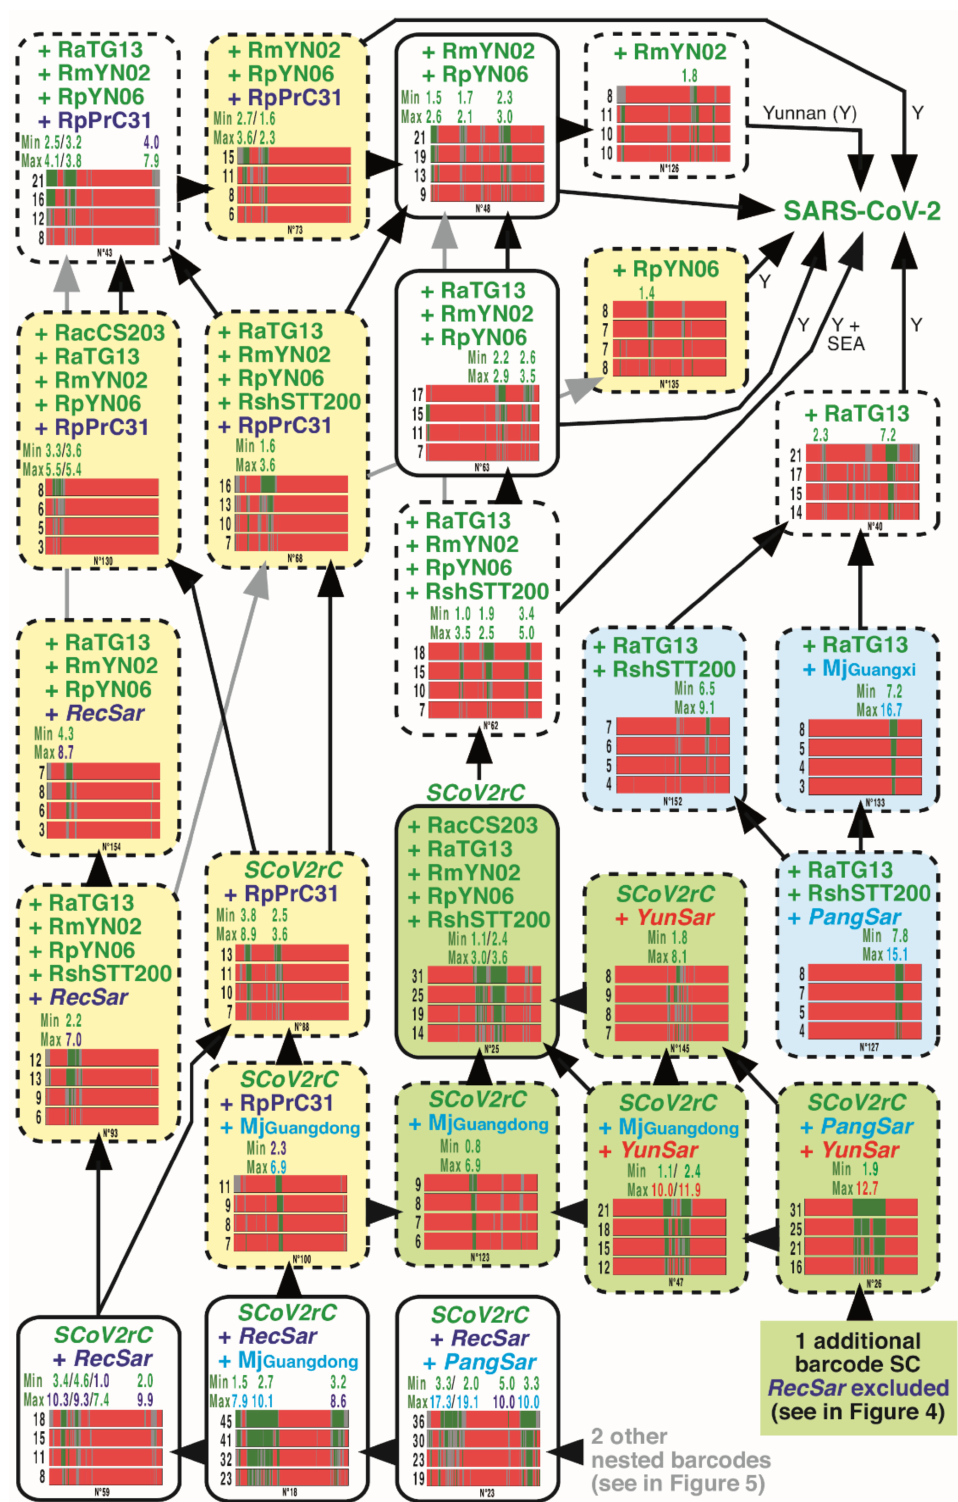
Figure 7. Genomic bootstrap (GB) barcodes generated for the bipartitions including SARS-CoV-2. The GB barcodes were examined for the 33 bipartitions including SARS-CoV-2 found in the SWB analyses based on four window sizes (250, 500, 1000, or 2000 nt) and supported by MBP 2000 > 7%. The GB barcodes of the eight largest bipartitions (N ◦ 17, 37, 41, 46, 54, 117, 120, and 129) are not shown; they are available in Figures 4–6. For more details on GB barcodes, read the legend of Figure 4. Here, the GB barcodes with MBP 2000 < 7% were not